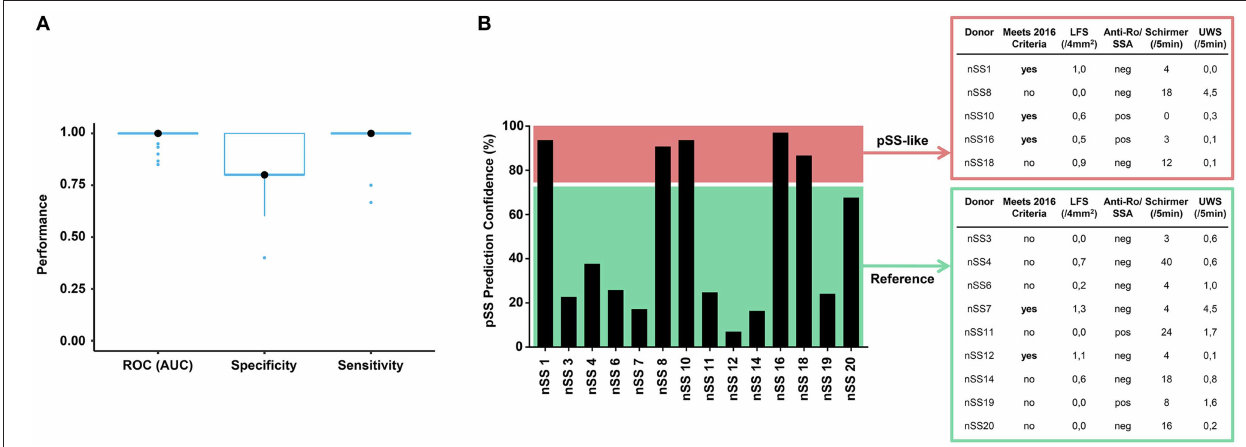
FIGURE 6 | Prediction model discriminates between pSS and HC donors and identifies group of nSS patients more likely to meet the newest classification-criteria. After batch correction of the sequencing data from both cohorts, a selection of 467 genes from the replicated gene signatures was used to build a discriminative classifier that distinguishes between pSS and HC donors. (A) shows the performance of the discriminative classifier as validated using 10-fold cross validation. The transcriptional data of the nSS patients from both cohorts were entered into the classifier and a set of “pSS-like” donors (prediction confidence > 75%) was identified. nSS patients with lower prediction confidence ( < 75%) were included as “Reference” group. Fourteen nSS donors from either group were clinically re-evaluated in the context of the new 2016 classification-criteria for pSS at (median [IQR]) 3.5 [2.9–3.9] years after initial sample collection (B)